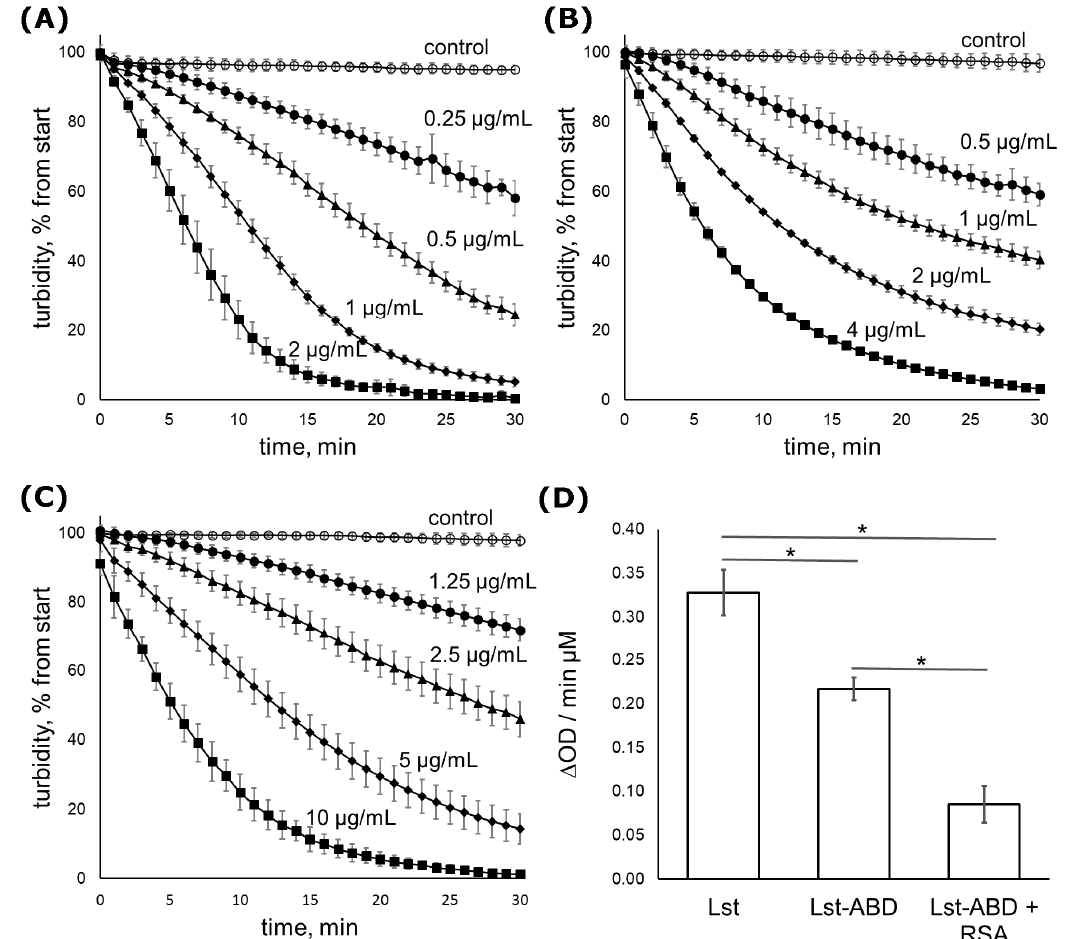
Figure 2. Time-dependent clearing of S. aureus ATCC 29,213 cell suspension by lysostaphin and Lst-ABD. ( A ) Lysostaphin: 2 µ g / mL (squares), 1 µ g / mL (diamonds), 0.5 µ g / mL (triangles), 0.25 µ g / mL (circles), or control (no protein, open circles). ( B ) Lst-ABD: 4 µ g / mL (squares), 2 µ g / mL (diamonds), 1 µ g / mL (triangles), 0.5 µ g / mL (circles), or control (no protein, open circles). ( C ) Lst-ABD in the presence of RSA: 10 µ g / mL (squares), 5 µ g / mL (diamonds), 2.5 µ g / mL (triangles), 1.25 µ g / mL (circles), or control (no protein, open circles). The protein concentrations are also indicated in the figure above the corresponding curves ( D ) The rate of cell suspension clearing adjusted to 1 µ M of protein. Mean values from three independent experiments are shown, error bars represent standard deviation. Statistical significance was assessed by one-way ANOVA with Tukey’s Honest Significant Di ff erence post-hoc analysis. All di ff erences between the means were significant with p < 0.01. Lysostaphin data are reproduced from